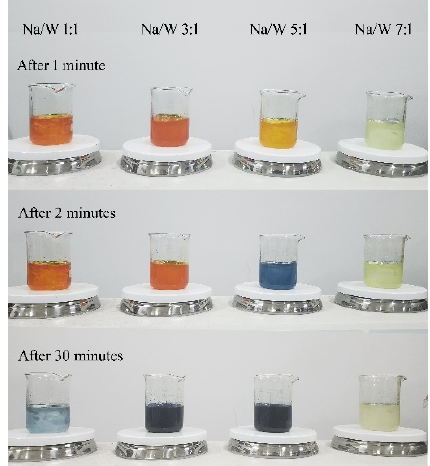
Figure 1. As-prepared precursor solutions with different molar ratio of Na/W after different times.